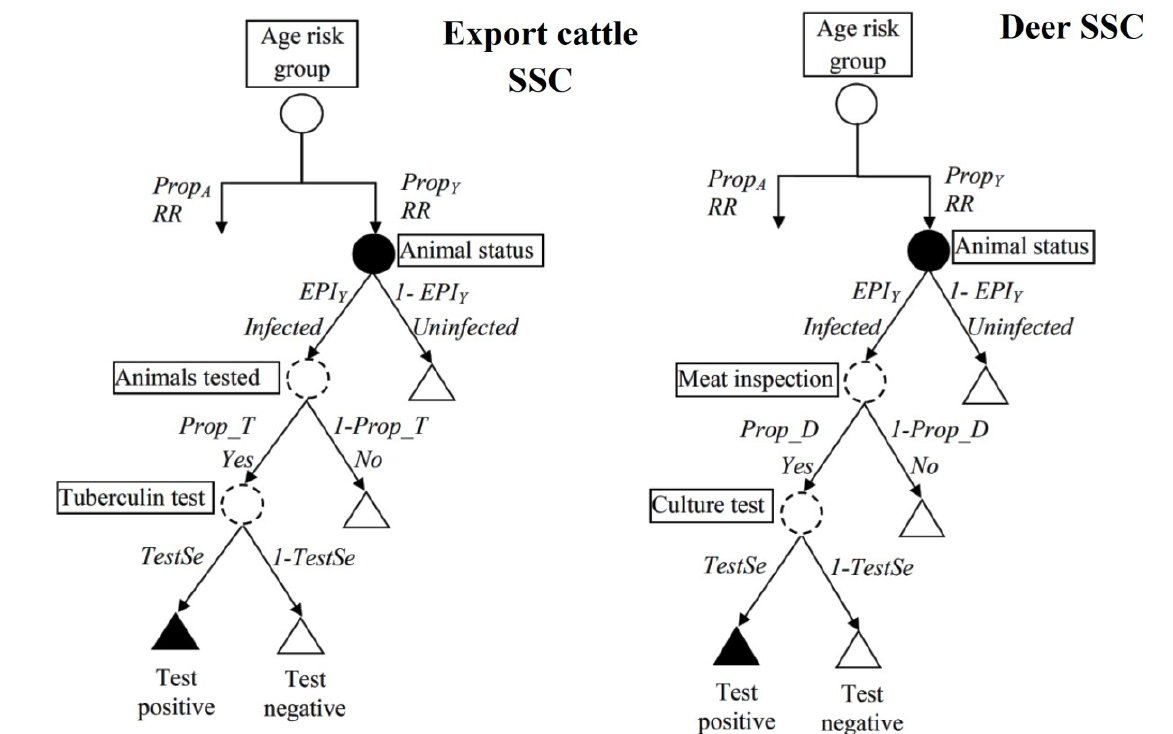
Figure 2. Conceptual scenario tree developed to evaluate the performance of the four surveillance system components (SSCs) for detection of bovine tuberculosis (bTB) at meat inspection in Denmark. Prop and Prop are proportions of animals in the adult and young A Y risk groups, respectively, and RR is the respective relative risk. EPI is the effective Y probability of infection in the young animal group. Prop_T , Prop_D , Prop_L and Prop_S are the proportions of animals for each detection node according to the current invasive meat inspection procedures for bTB and its corresponding